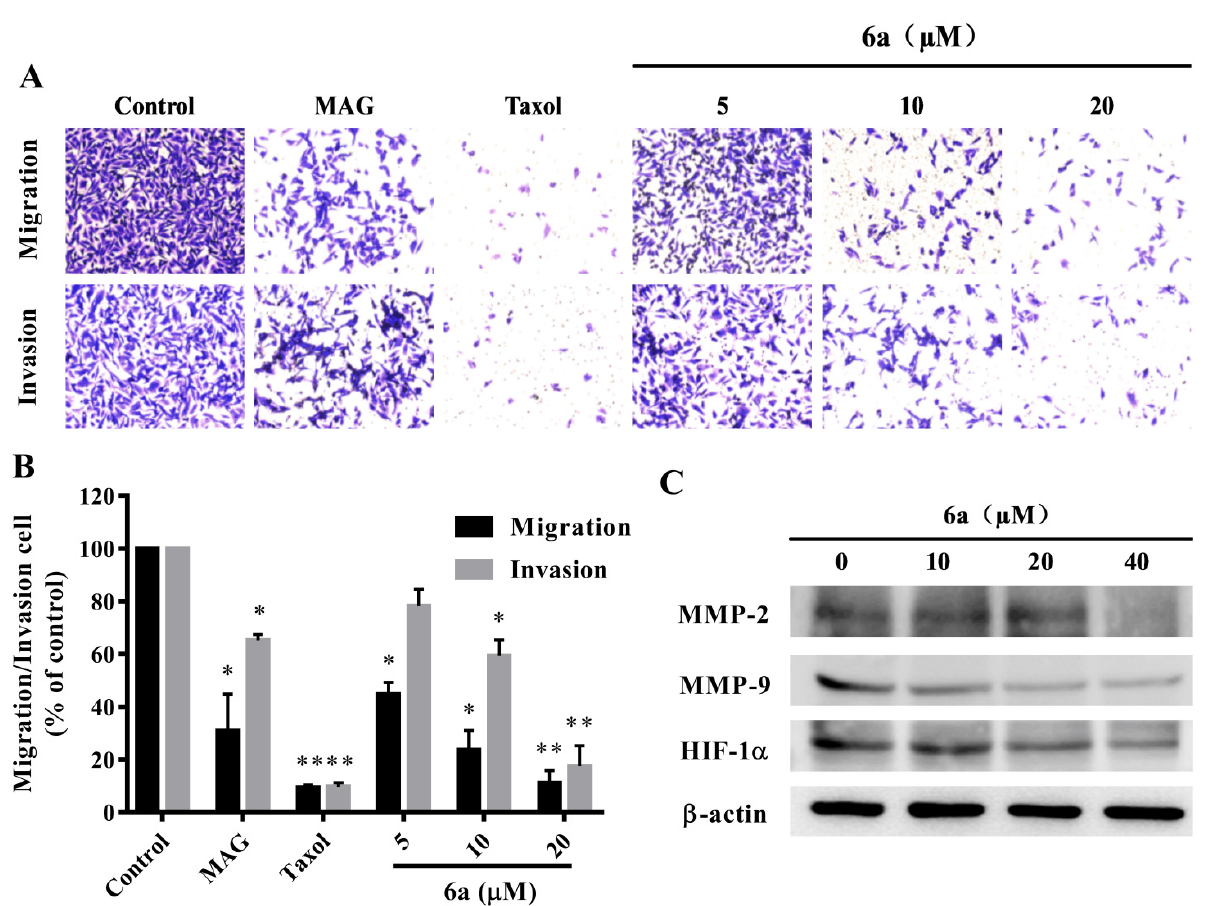
Figure 4. Effects of compound 6a on the migration and invasion of human triple-negative MDA-MB-231 breast cells by transwell assays. ( A ) MDA-MB-231 cells were seeded into a transwell chamber and exposed to 6a (0, 5, 10, and 20 µ M) for 24 h to evaluate the migration activity; MDA-MB-231 cells were also seeded into a Matrigel-coated transwell chamber and exposed to 6a (0, 5, 10, and 20 µ M) for 36 h to evaluate the invasion activity (original magnification 200 × ). ( B ) Quantification analysis presented as the mean ± standard deviation. ** p < 0.01, * p < 0.05 vs. control ( n = 3). ( C ) Western blotting analyses of HIF-1 α , MMP-2, and MMP-9 protein levels in MDA-MB-231 cells treated with various concentrations (0, 10, 20, and 40 μ M) of 6a for 24 h. β -Actin was used as an internal control.